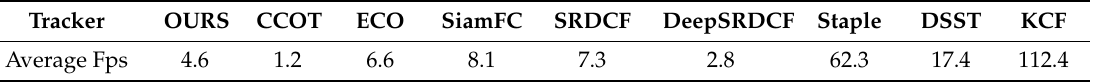
Table 3. Speed of trackers related in frames per second (fps).